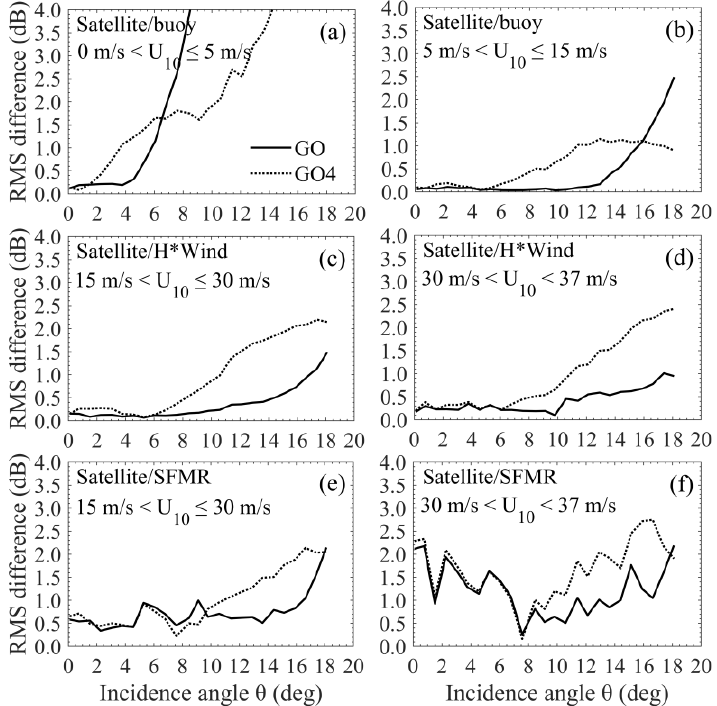
Figure 8. RMS differences between the NRCSs computed with the fitted GO (solid lines) and GO4 (dotted lines) models and the bin-averaged NRCS measurements from ( a , b ) the satellite/buoy data, ( c , d ) the satellite/H*Wind data, and ( e , f ) the satellite/SFMR data as functions of incidence angle at different wind conditions.